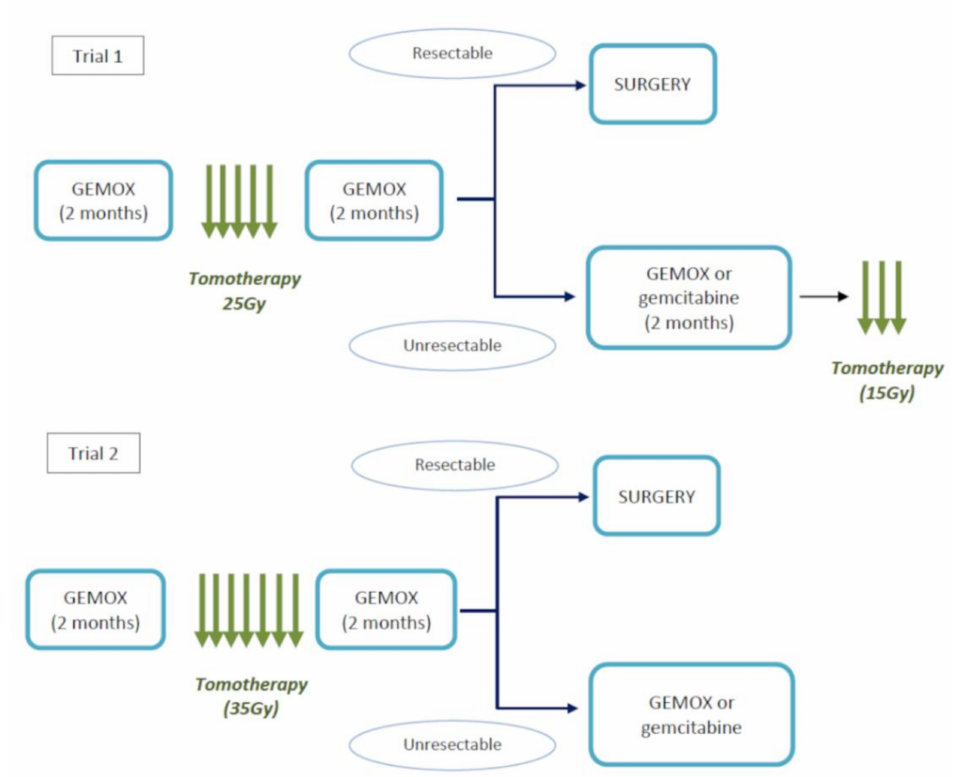
Figure 1. Treatment strategy with chemotherapy (GEMOX) and tomotherapy. In trial 1 [20],